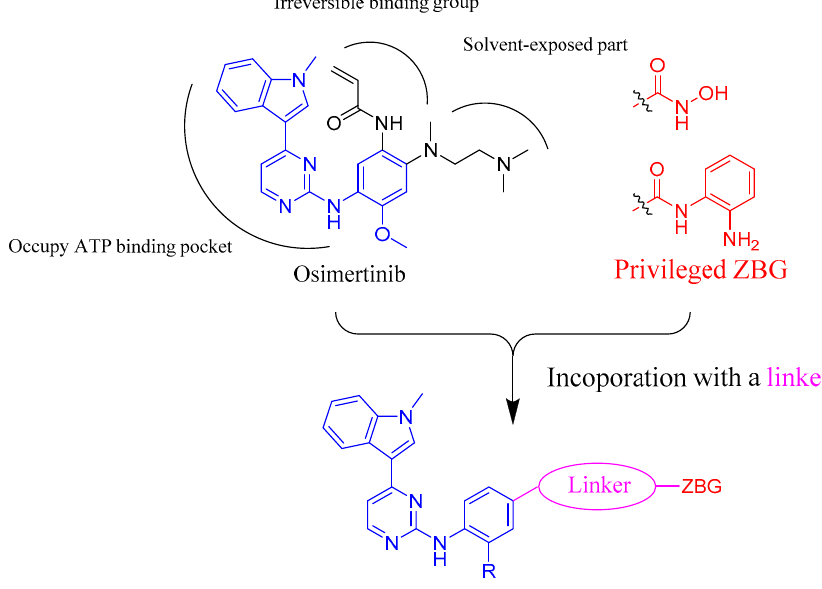
Figure 3. Design strategy of osimertinib-based HDAC and EGFR dual inhibitors.